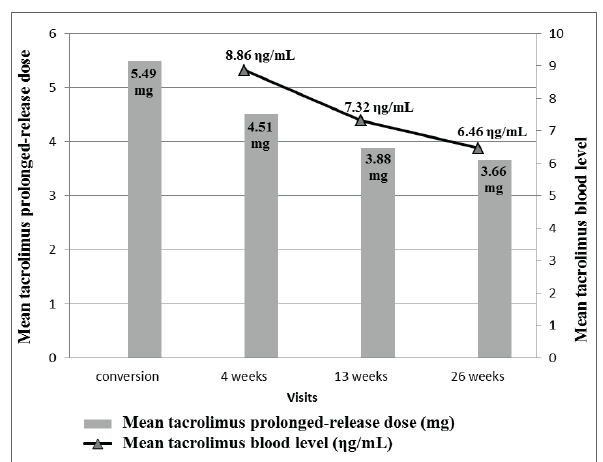
Fig. 1. changes in mean tacrolimus prolonged-release dose and mean tacrolimus blood levels during the 26-weeks